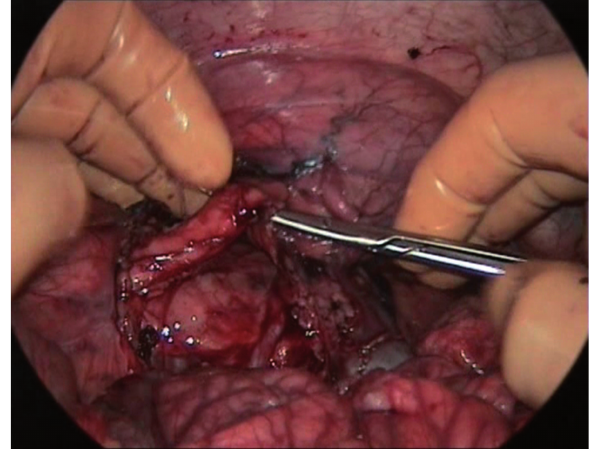
figure 2 - The ureter is been shown. At the bottom, in between the hands, is the right kidney covered by the